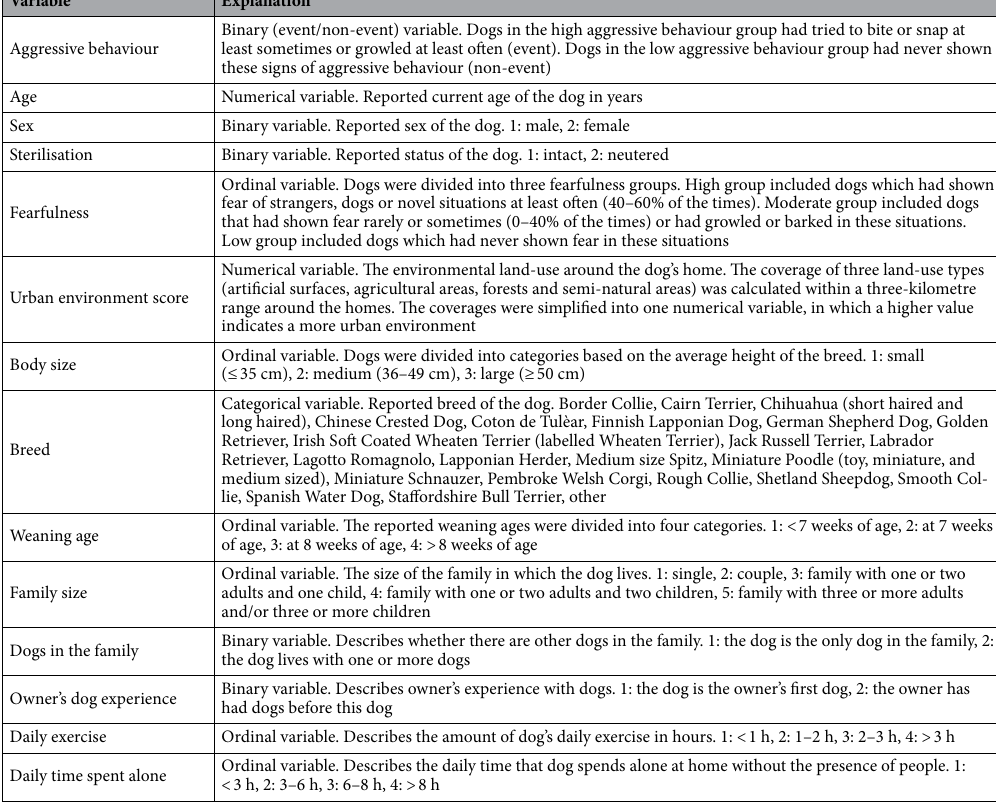
Table 3. The variables and their categories used in the model selection of aggressive